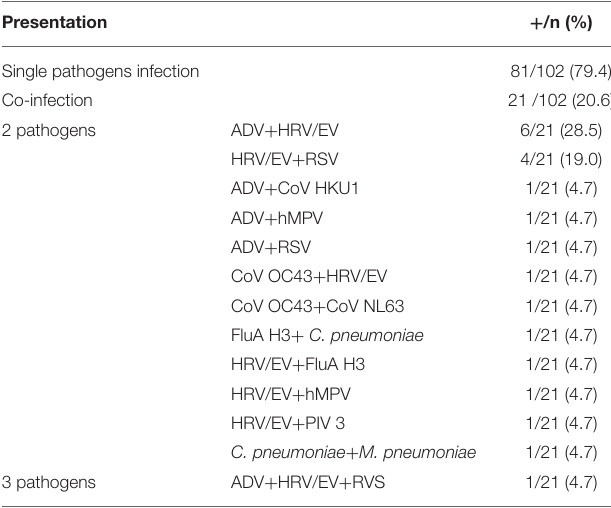
TABLE 2 | Reported cases of respiratory pathogens co-infection in the study